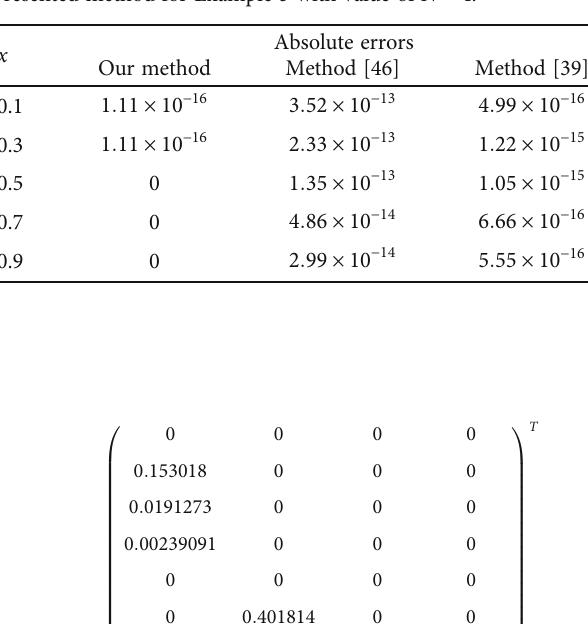
Table 6: The comparisons between the absolute errors of the presented method for Example 5 with value of N = 4